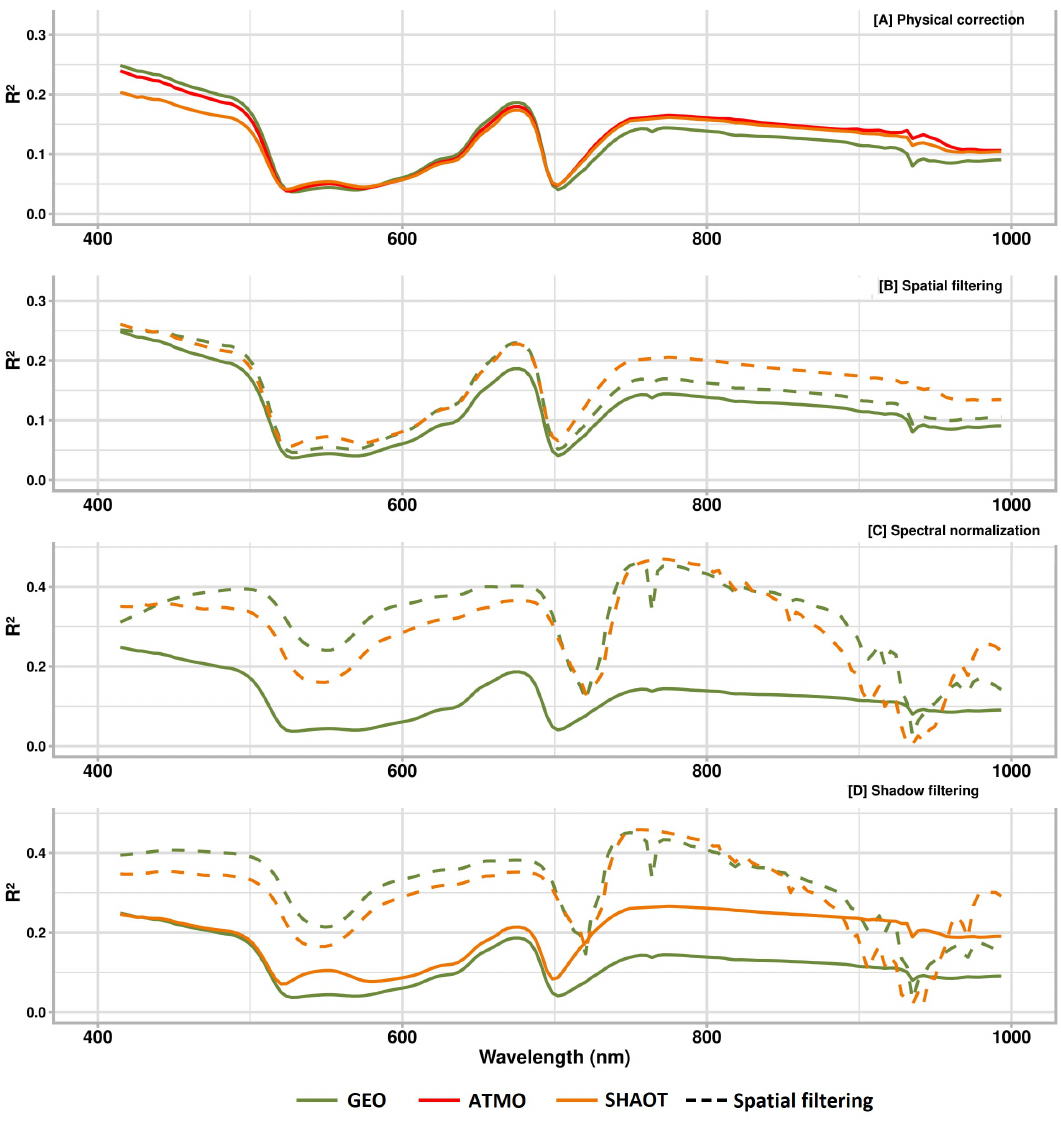
Figure 3. Proportion of variance explained by tree species identity (20 species) for each wavelength (data acquired on 19 September). L1b (GEO in green solid line) is plotted on each graphic as a reference. ( A ) After atmospheric corrections only. ( B ) After spatial filtering (either alone or in addition to atmospheric corrections). ( C ) After normalisation applied to spatially filtered data. ( D ) After additional shadow